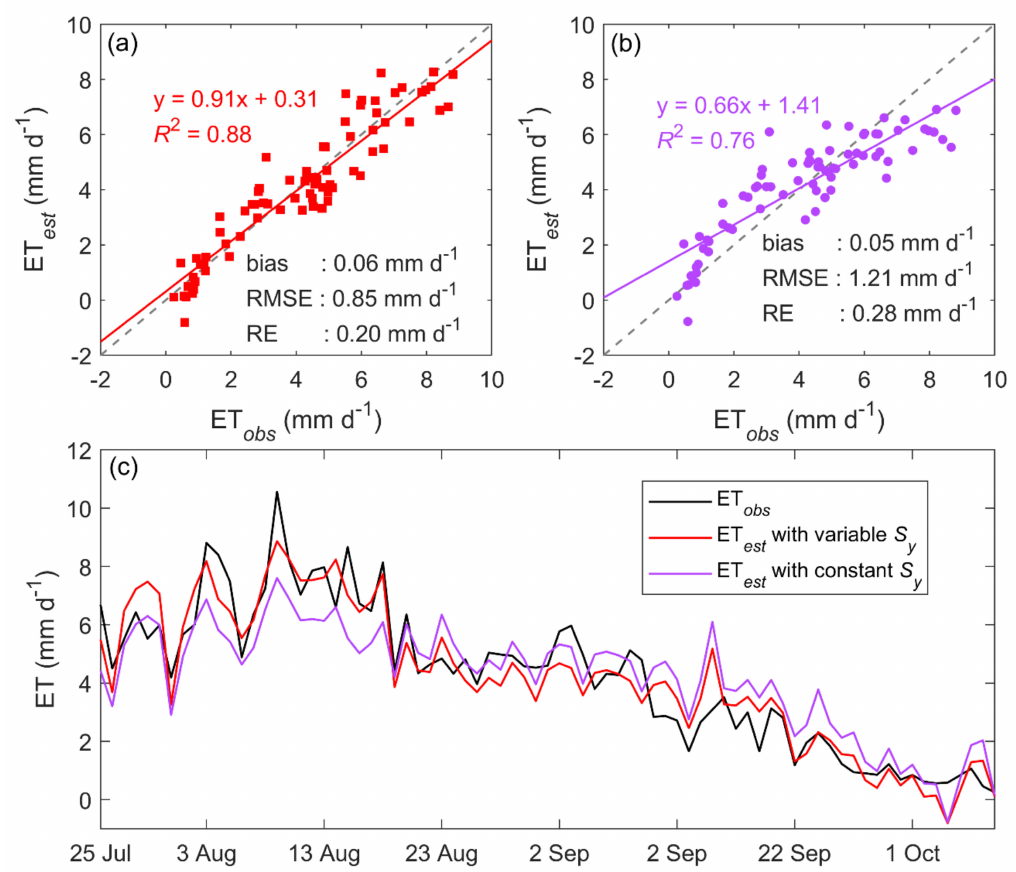
Figure 6. Comparisons between measured and estimated daily ET based on different Sy calibration procedures: ( a ) dataset-by-dataset procedure; ( b ) whole dataset procedure; and ( c ) seasonal variations of the measured and estimated daily ET based on different Sy calibration